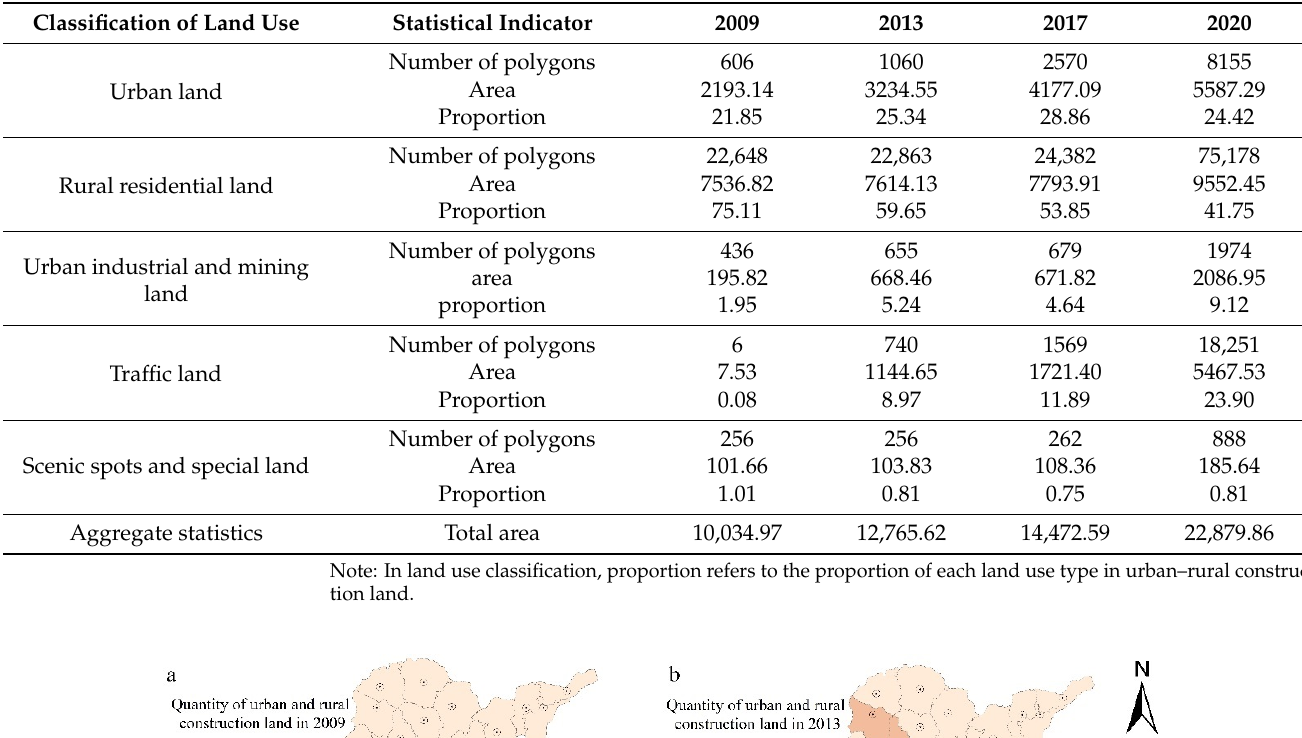
Table 2. Quantity of change in urban–rural construction land in Qixingguan District (2009–2020) (hm 2 , %).